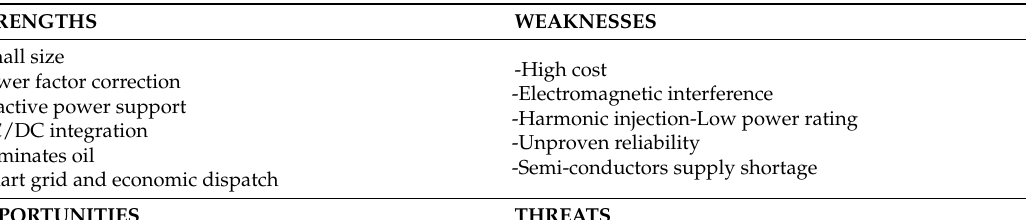
Table 3. SWOT analysis for